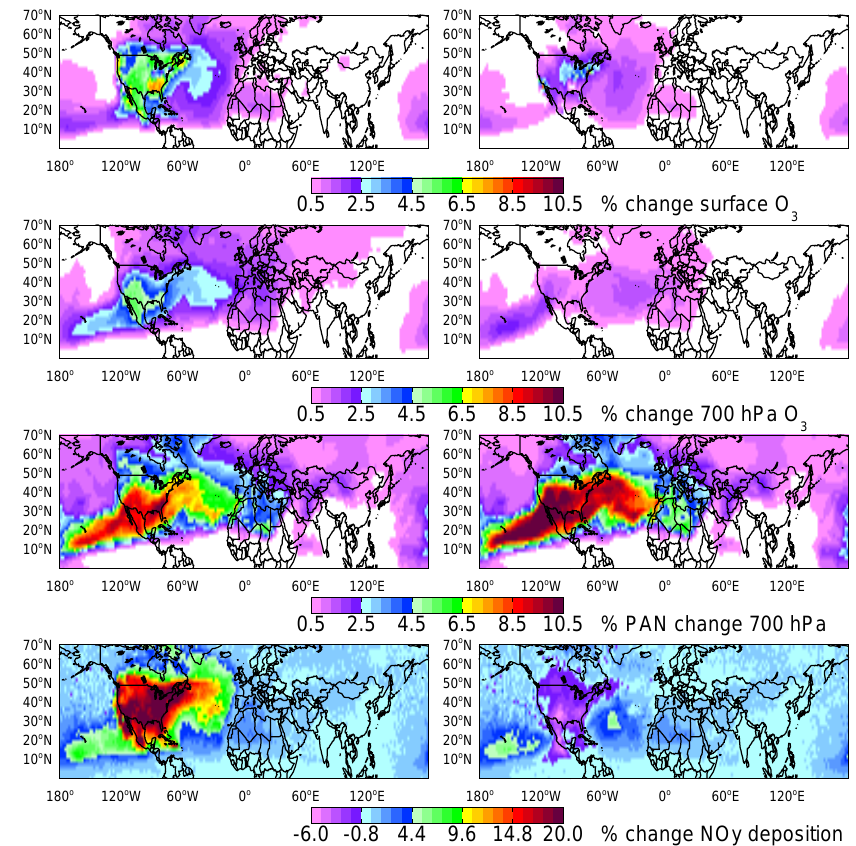
Fig. 3. Percentage decrease (left) and increase (right) in surface O 3 (first row), O 3 at 700hPa (second row), PAN at 700hPa (third row), and NO y deposition (bottom row) resulting from 20% decreases in NA anthropogenic O 3 precursor emissions (SR1-SR6NA simulations; left) and 20% increases in biogenic isoprene emissions (ISOPNA-SR1; right) in the MOZART-2 model during August of 2001. Note the different scales on each color bar. Areas in white fall below the minimum value